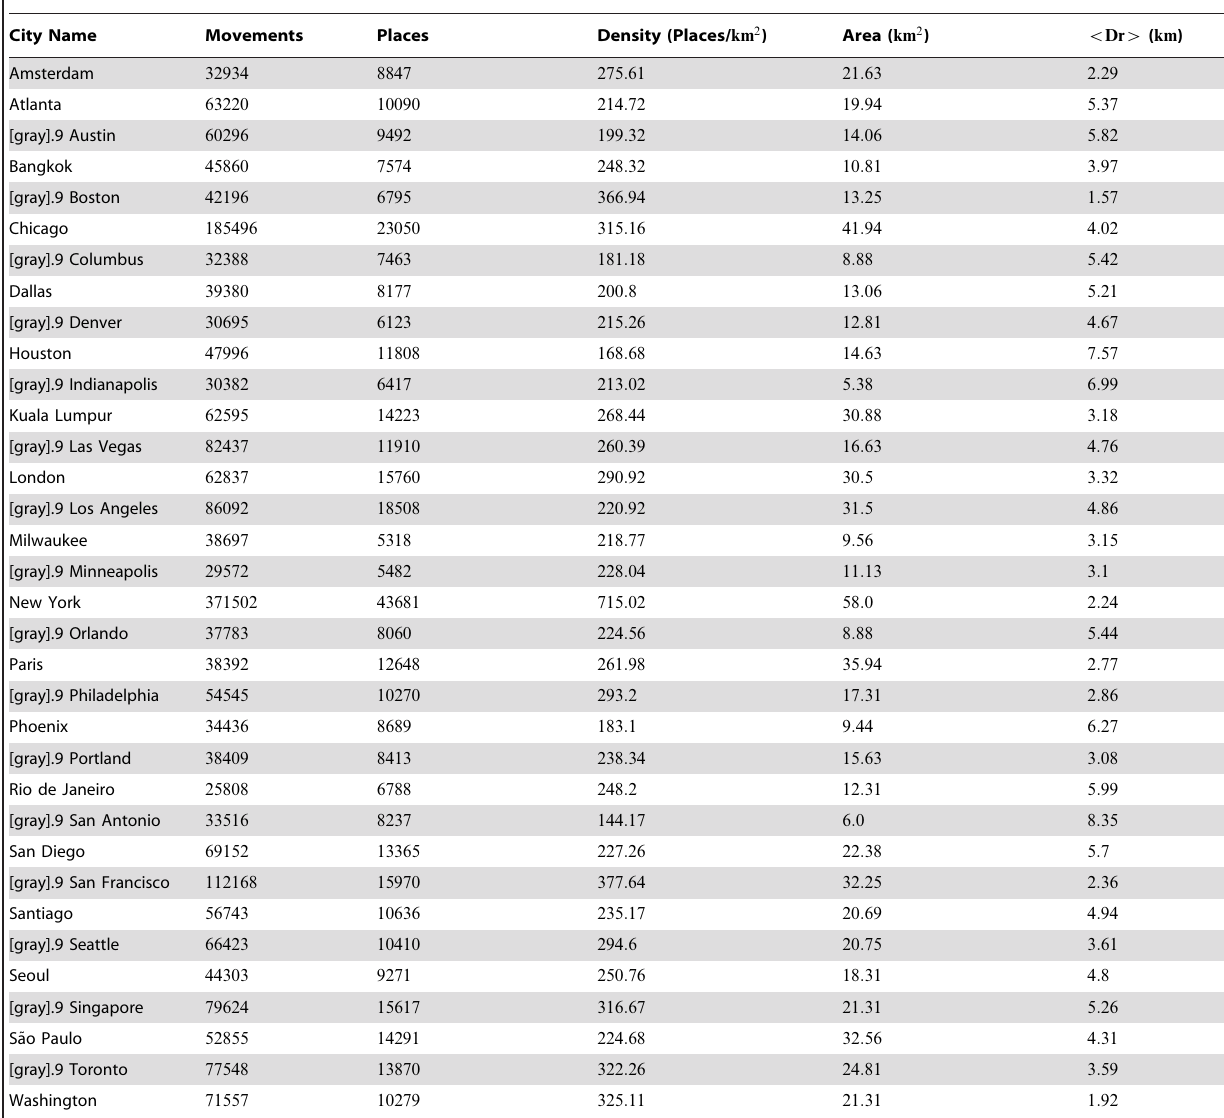
Table 1. Summary of city